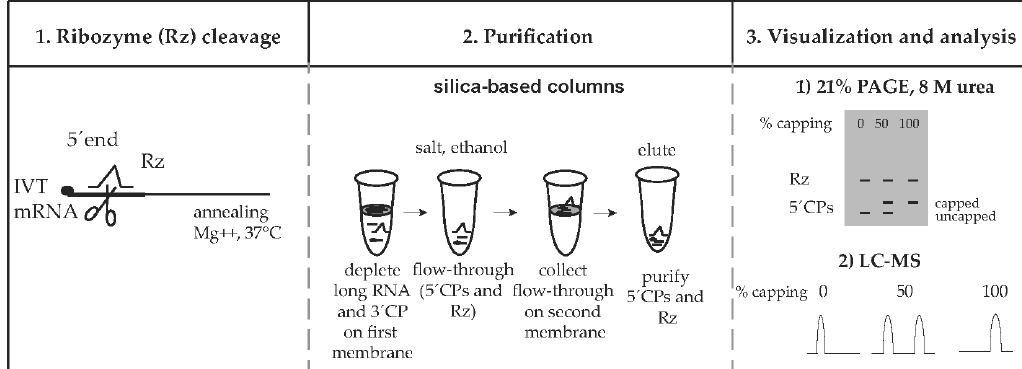
Figure 1. Ribozyme-mediated cleavage to quantify the capping efficiency of in vitro-transcribed mRNA. Ribozyme (Rz) anneals to IVT mRNA and cleaves the 5 ′ -end of the IVT mRNA at 37 °C in the presence of Mg ++ . Substrate cleavage results in a mixture of RNAs: Short capped and uncapped 5 ′ cleavage products (5 ′ CPs), long 3 ′ cleavage products (3 ′ CPs), long uncleaved RNAs, and the Rz. The mixture is purified using a process with two silica-based columns, whereby the long RNAs and 3 ′ CPs are depleted on the first column membrane using specific salt and ethanol conditions. The collected flow-through containing the short capped and uncapped 5 ′ CPs is applied to the second column, bound on its membrane, and eluted in water. The purified 5 ′ CPs and Rz are visualized using 21% PAGE, 8 M urea or analyzed with liquid chromatography and mass spectrometry (LC–MS), allowing for the quantification of capping efficiency of the IVT mRNA.